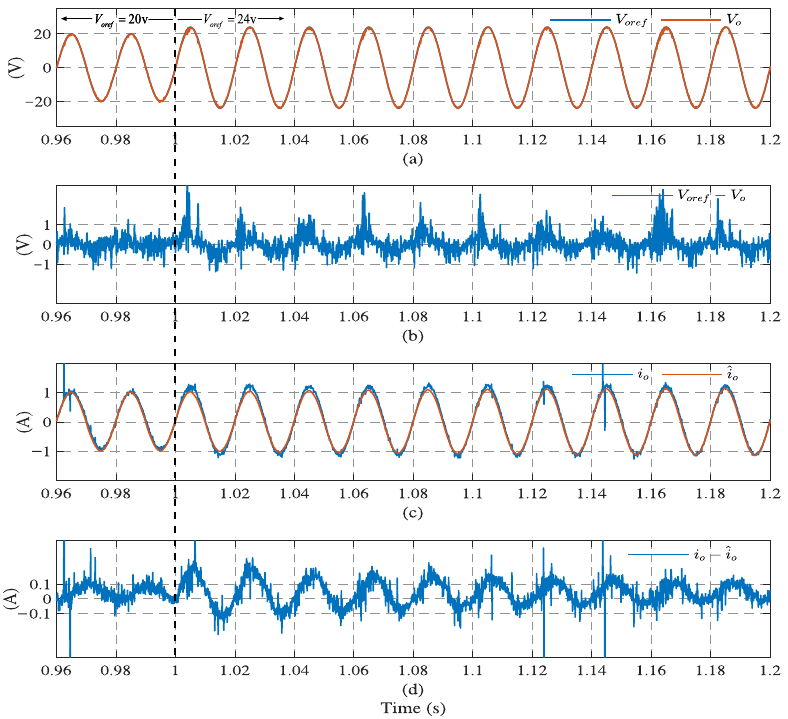
Figure 13. System dynamic response results using observer under linear load: ( a ) output voltage, ( b ) voltage tracking error, ( c ) load current, and ( d ) current estimation